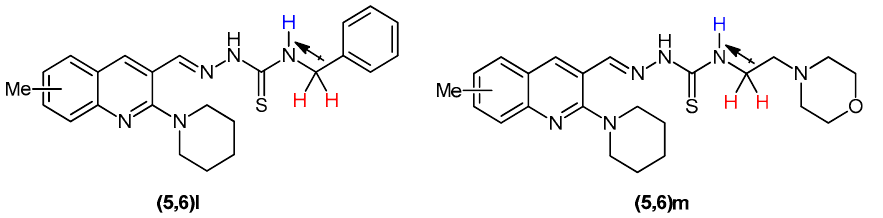
Figure 3. Upfield shifting and splitting of –NH signal in 5(l,m) and 6(l,m) . 13 C NMR spectra further confirmed the newly formed structures by showing the peak for C=S carbon as the most deshielded signal around 175.5–178.5 ppm. The peaks of the